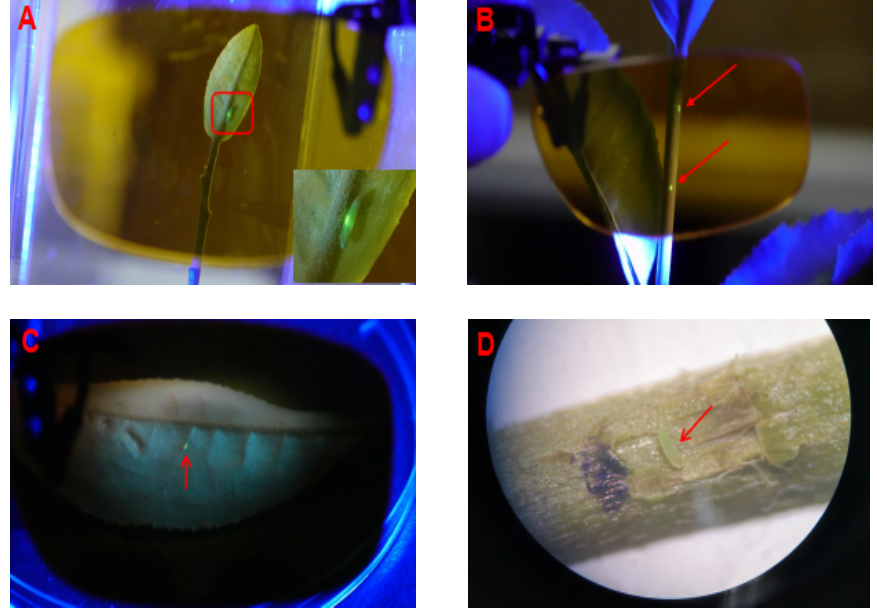
Figure 1. Images of E. onukii eggs under the blue light detection method (BLDM): ( A ) gravid female (enlarged size of E.onukii female laying on the lower right corner); ( B ) eggs on the tender stem; ( C ) egg on the leaf vein; and ( D ) an egg detected by stereomicroscope.